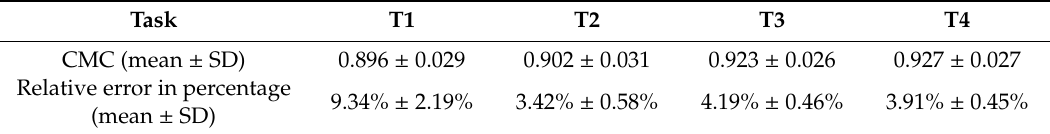
Figure 7. Low-back compression force of one participant acquired from the developed system and 3DSSPP for four manual handling tasks (T1–T4). Table 4. Coefficient of multiple correlation (CMC) and relative error in percentages between the 2D low-back compression force (unit: Newton) generated from the developed system and 3DSSPP for four selected manual handling tasks (T1–T4).